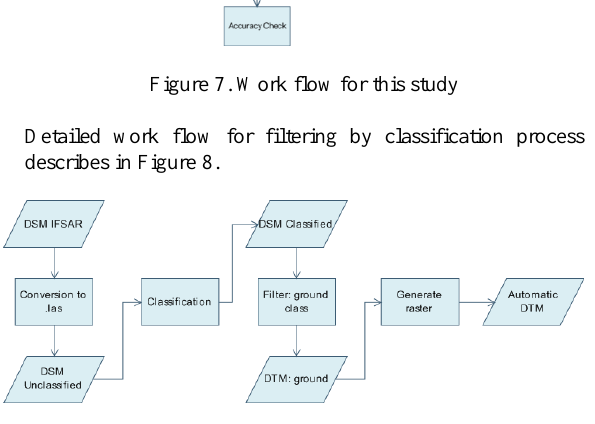
Figure 8. Work flow for an utomatic DTM